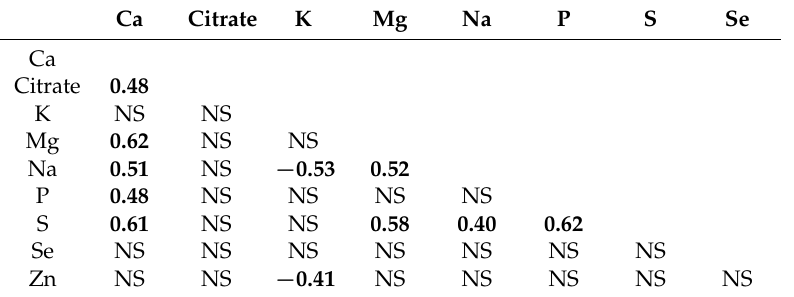
Table 7. Correlations between milk mineral concentrations. Correlations ≤− 0.40 and ≥ 0.40 are significant ( p < 0.05) and are in bold. Ca Citrate K Mg Na